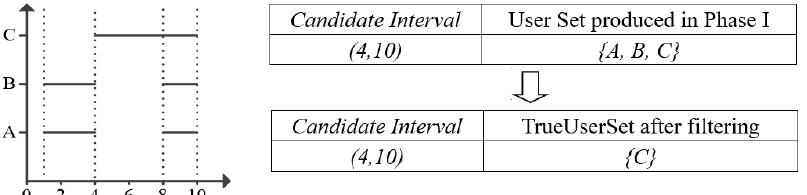
Figure 7. Example in Phase II.